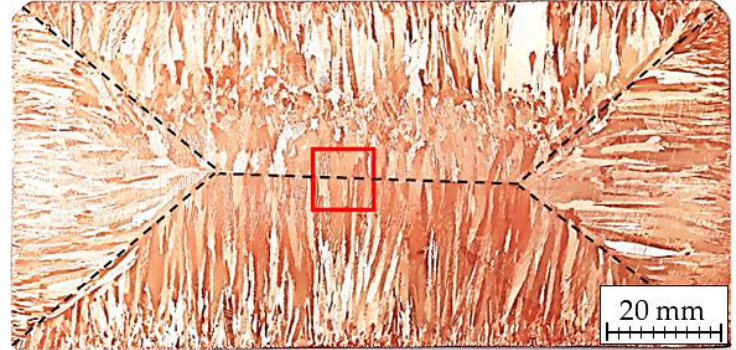
Figure 1. Macroscopic image of the tested ETP grade copper strand with marked area of the conducted light microscope